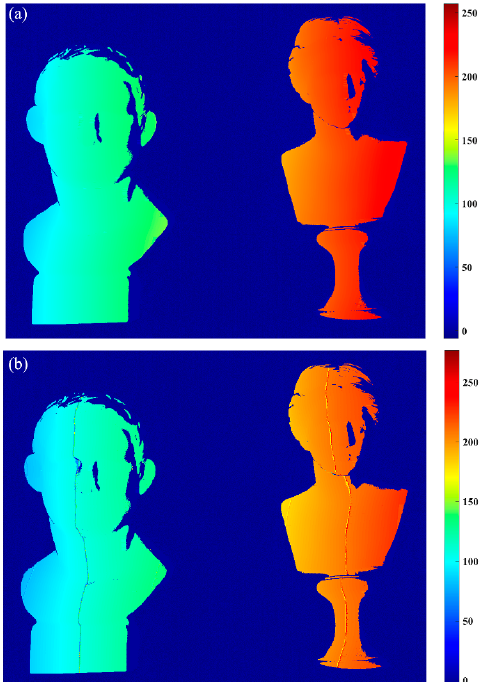
Figure 13. The absolute phase maps. ( a ) n GC method, ( b ) n GL method.